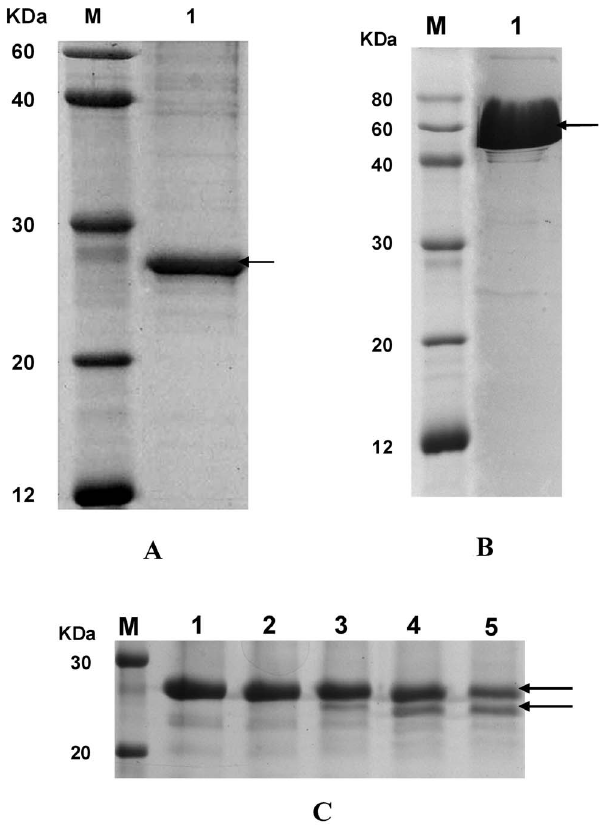
Figure 1. SDS-PAGE results of purified SNAP25 and ALc, as well as cleaved SNAP25 by BoNT/A and ALc. A) SDS-PAGE result of purified SNAP25. M: marker; 1: purified SNAP25. B) SDS-PAGE result of purified ALc. M: marker; 1: purified ALc. C) SDS-PAGE result of purified SNAP25 mixed with ALc. M: marker; 1: 10 m l of SNAP25; 2: 10 m l of SNAP25 + 5 m l of ALc; 3: 10 m l of SNAP25 + 10 m l of ALc; 4: 10 m l of SNAP25 + 15 m l of ALc; 5: 10 m l of SNAP25 + 20 m l of ALc.